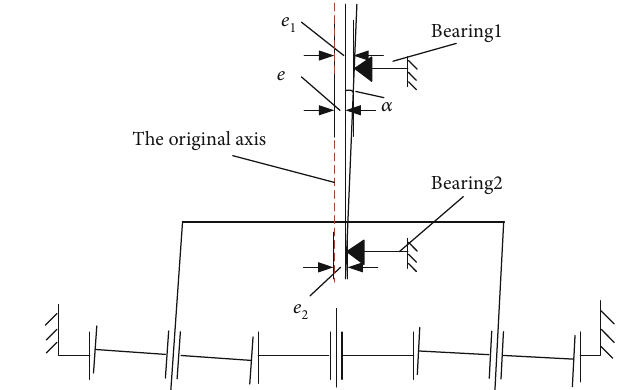
Figure 3: The theoretical analysis diagram of the shaft system undergoing shafting position changes.